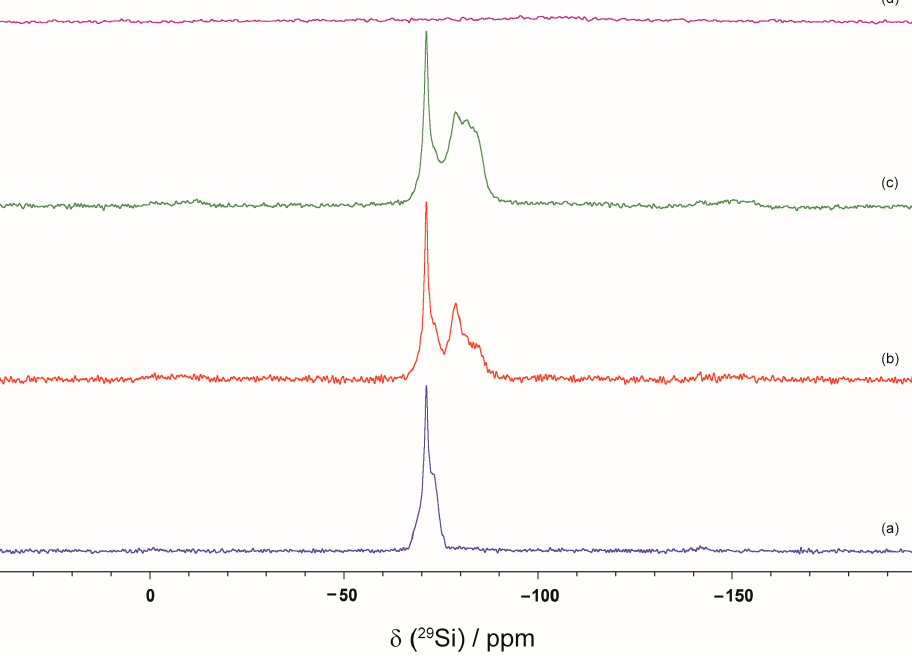
Figure 11. 29 Si MAS NMR spectra of ( a ) CEM, ( b ) CP, ( c ) CP10VSW and ( d ) VSW samples.